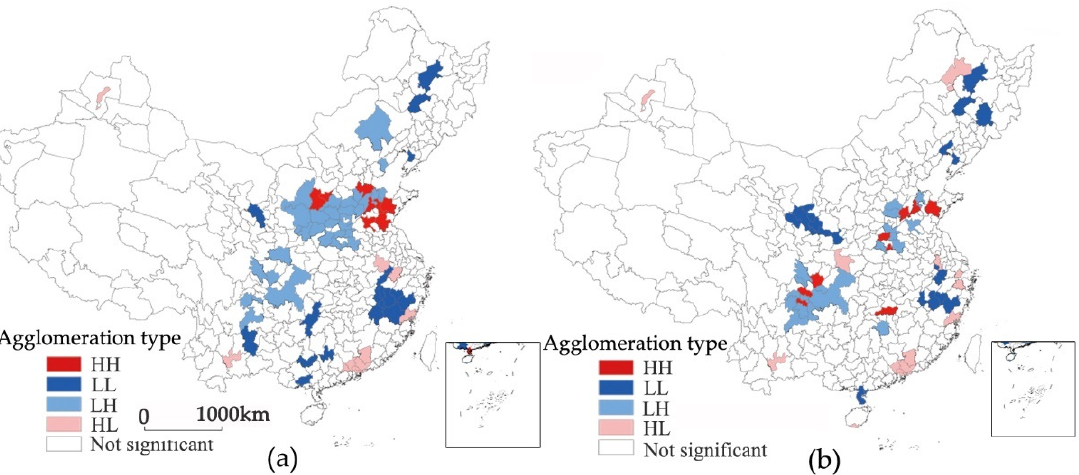
Figure 4. Bivariate LISA clustering of ER intensity. ( a ) Spatial lag of ER intensity in 2004; ( b ) spatial lag of ER intensity in 2011.